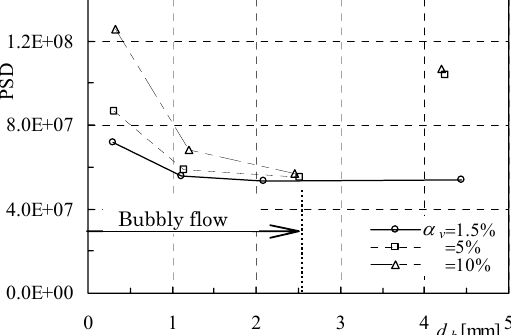
Fig.8 Pressure fluctuation amplitude in respect to mean bubble